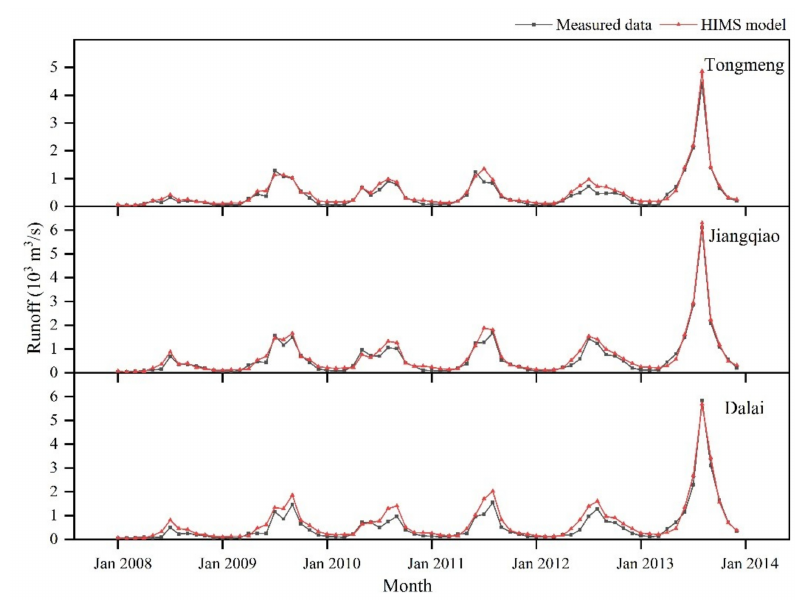
Figure 7. Simulation results of monthly runo ff in the reservoir operation period.